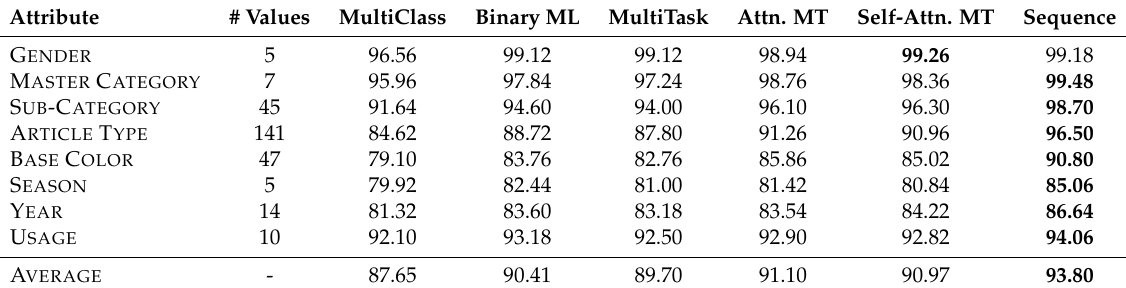
Table 4. Attribute level accuracies on the Kaggle test set for all models. Binary ML stands for Binary MultiLabel model, Attn. MT stands for Attentive MultiTask model, Self-Attn. MT denotes the Self-Attentive MultiTask